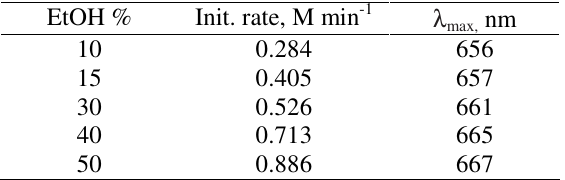
Table 1. Effect of ethanol % (v/v) on the maximum absorbance ( λ complex and intial rate of the reaction at T = 36 o C, [DPKTH] = 5 x 10 -4 M, [Fe 3+ ] = 1 x 10 -4 M, [Cysteine] = 2 x 10 -4 M and pH = 5